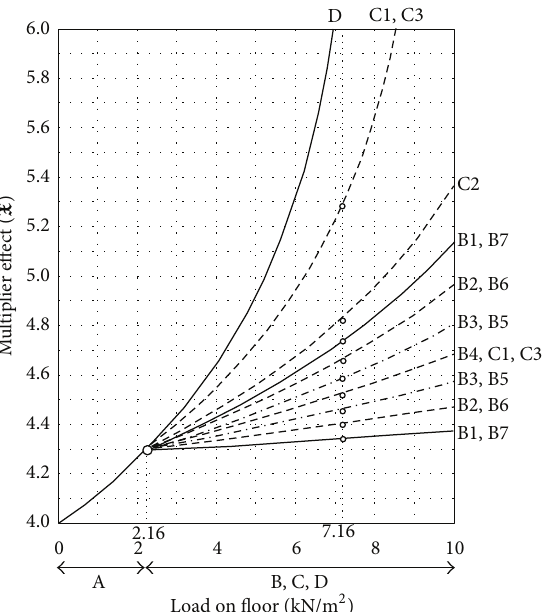
Figure 6: Multiplier ( X ). 𝐿 = 15 m. 𝐻 = 𝐿/30 . 𝛼 0 = 26.57 ∘ .